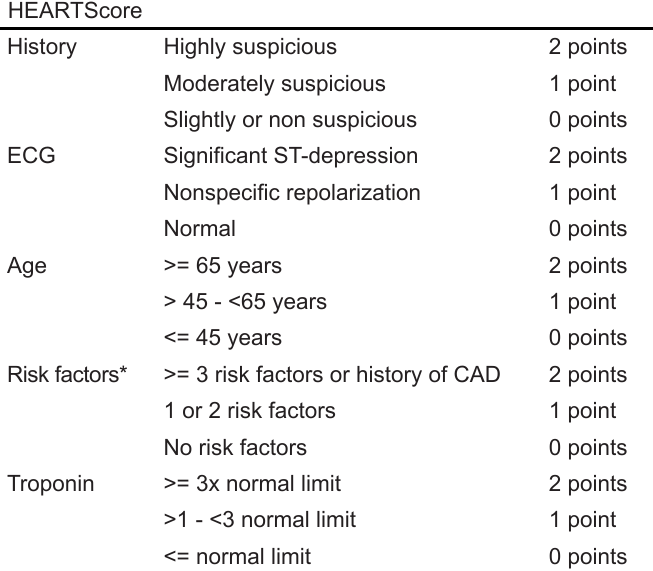
Table 3. Emergency Department Assessment of Chest Pain Score (EDACS).